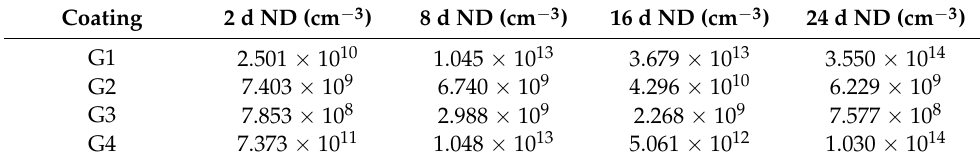
Table 3. Each EP/CeO 2 -GO coating’s carrier density for 2 d, 8 d, 16 d, 24 d.